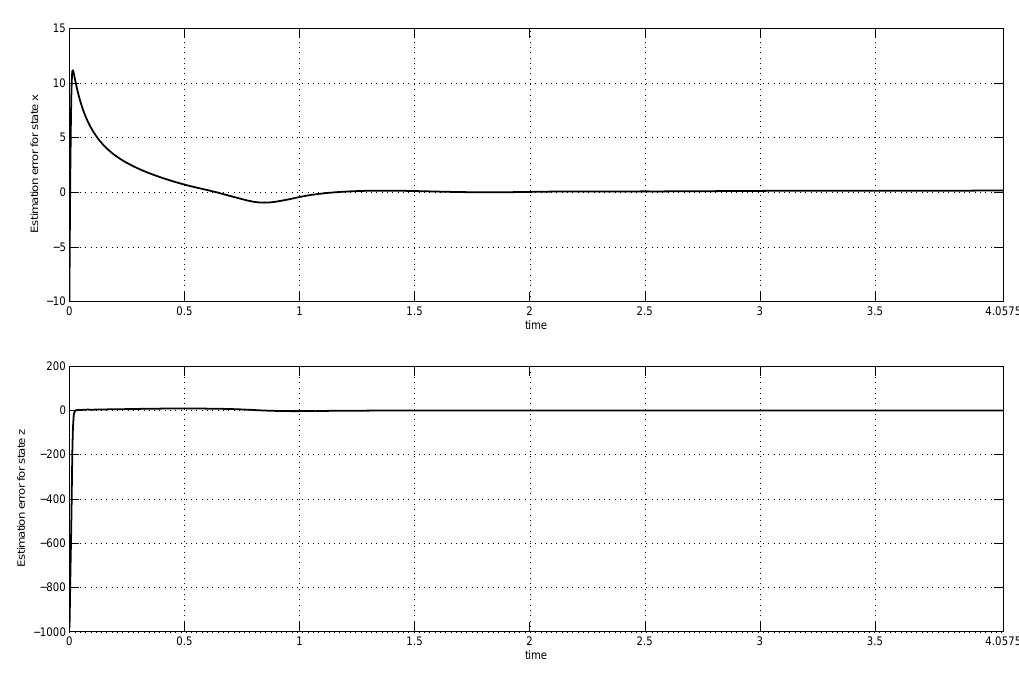
Figure 1: Top. Graph of the estimation error between the reference state x ( t ) (9) and its estimate m 2 ( t ) (14) in the interval [0 , 4 . 0575]. Bottom. Graph of the estimation error between the reference state z ( t ) (11) and its estimate m 1 ( t ) (13) in the interval [0 , 4 . 0575].